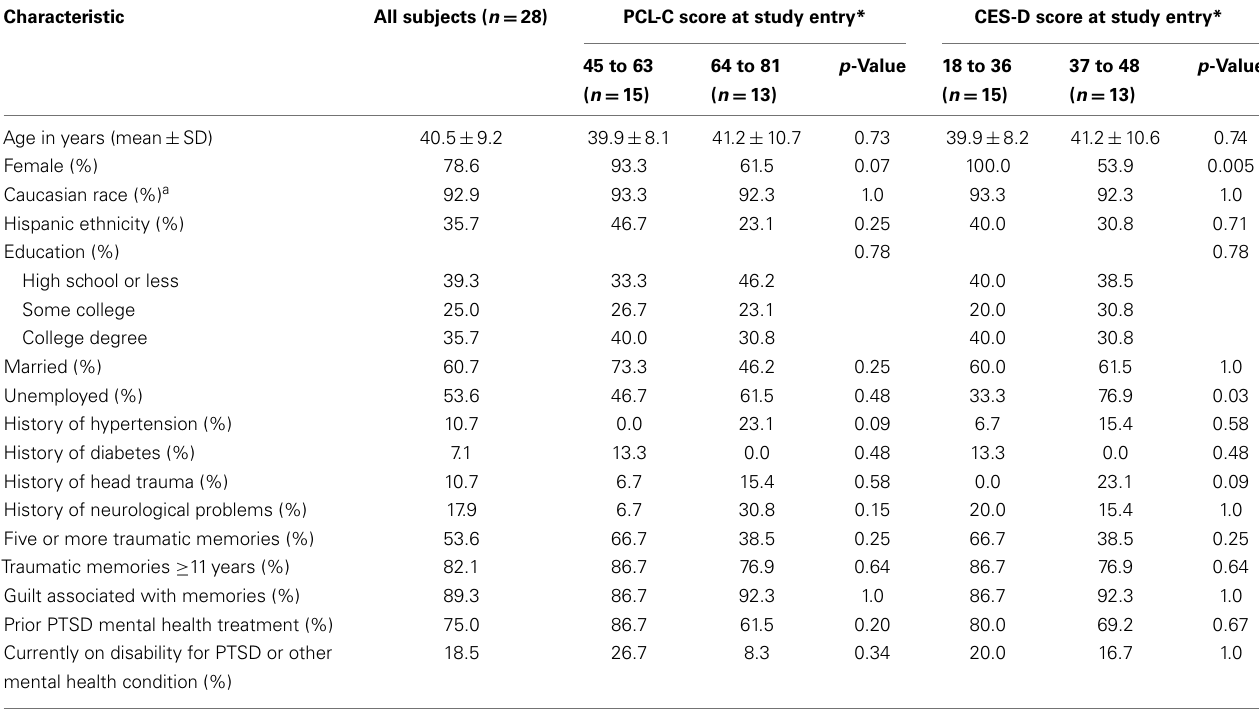
Table 2 | Demographic and presenting characteristics of study